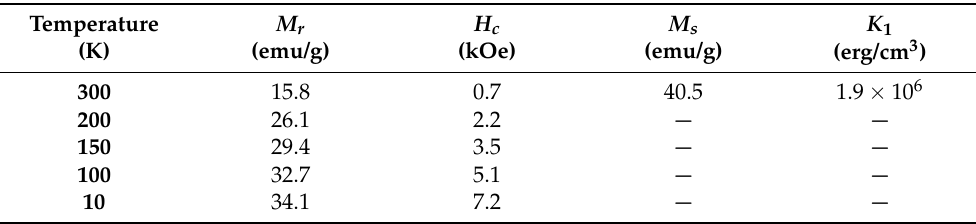
Table 2. Magnetic parameters for the Cu 0.75 Co 0.25 Fe 2 O 4 ferrite nanoparticles measured at various temperatures. The description of the parameters is given in the text.